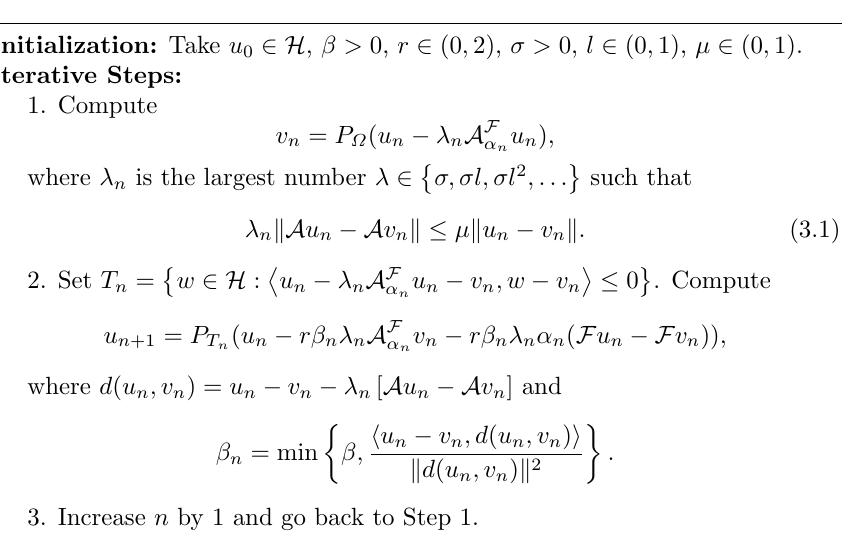
Algorithm 1. [Multi-Parameter Projection Method -